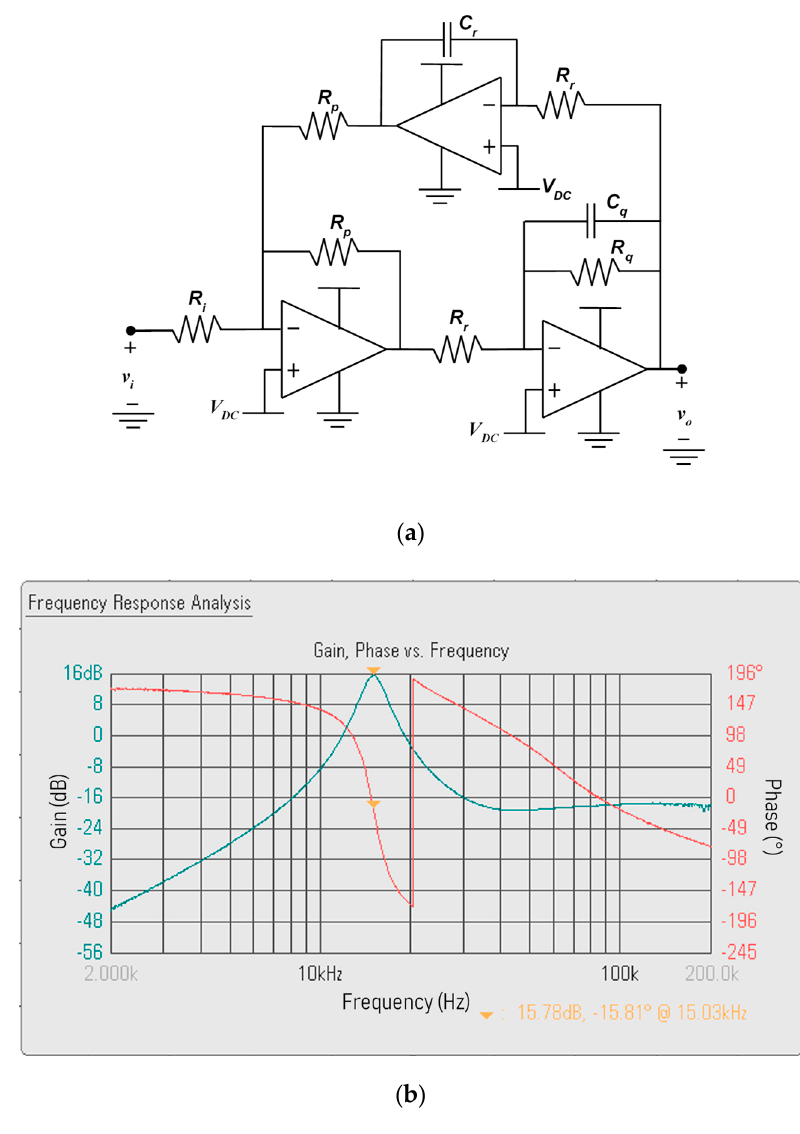
Figure 5. ( a ) Schematic of each one of the two stages of the reference frequency 4th-order band-pass